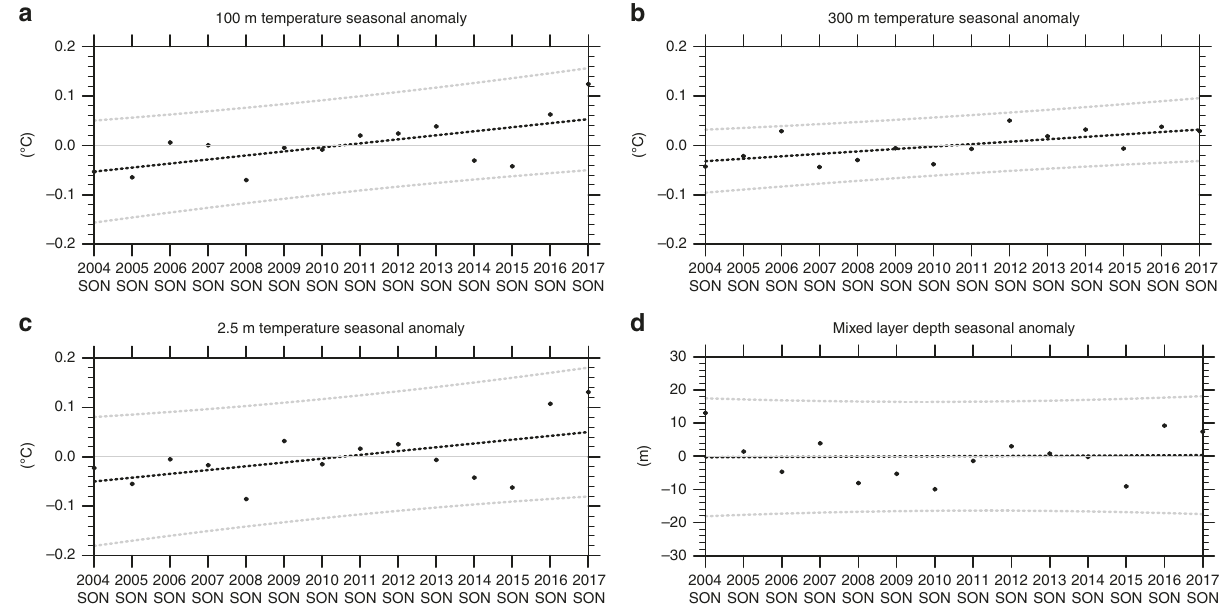
Fig. 5 Decadal timescale trends in the Southern Ocean. Time series of SON seasonal anomalies relative to 2004 – 2017 climatology averaged over 50 – 65°S from gridded Argo fl oat data for a temperature (°C) at 100-m depth showing a linear trend of + 0.08 °C decade − 1 , r 2 value of 0.41, signi fi cant at the 1% level; b temperature (°C) at 300-m depth showing a linear trend of + 0.05 °C decade − 1 , r 2 value of 0.40, signi fi cant at the 1% level; c temperature (°C) at 2.5-m depth showing a linear trend of + 0.08 °C decade − 1 , r 2 value of 0.28, signi fi cant at the 5% level, with the low r 2 value associated with the step increase of temperature in SON 2016; d mixed-layer depth (m) showing a linear trend of 0.5 m decade − 1 with an r 2 value near